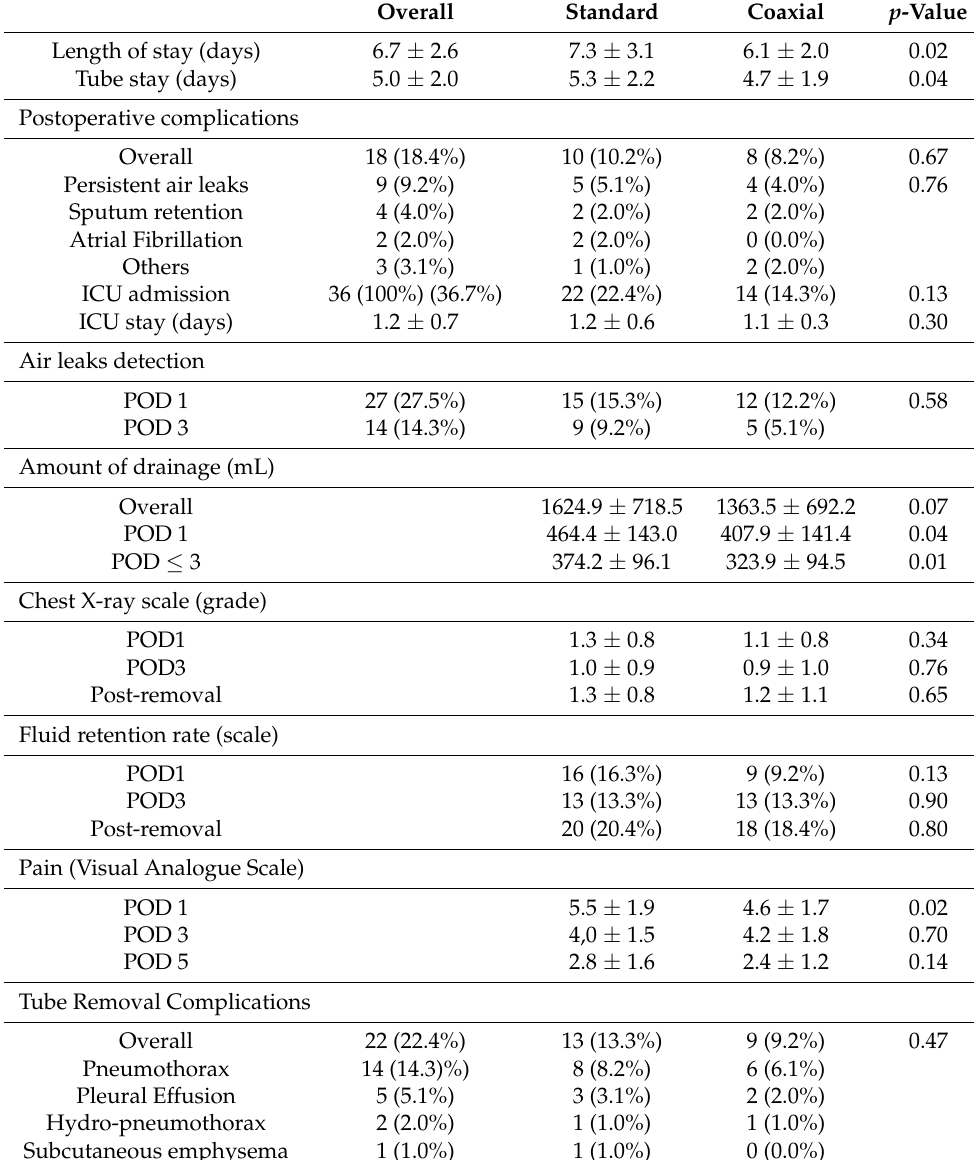
Table 2. Post-operative characteristics. Data are number (%) or mean ± standard